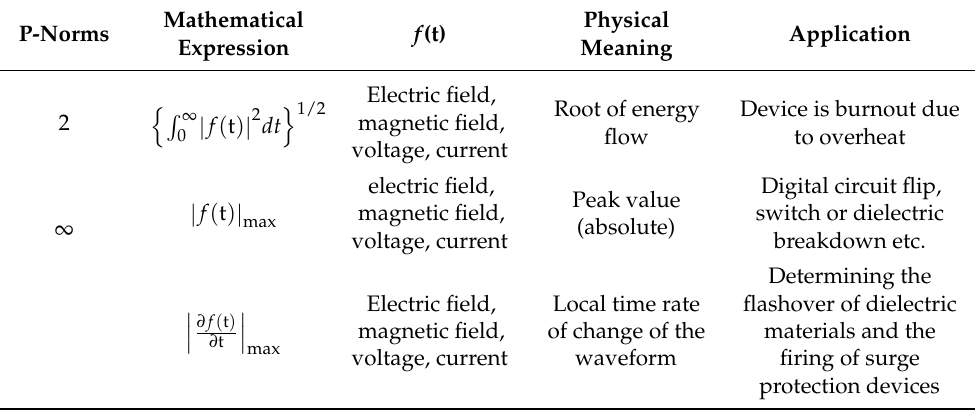
Table 1. P-norms applied in this